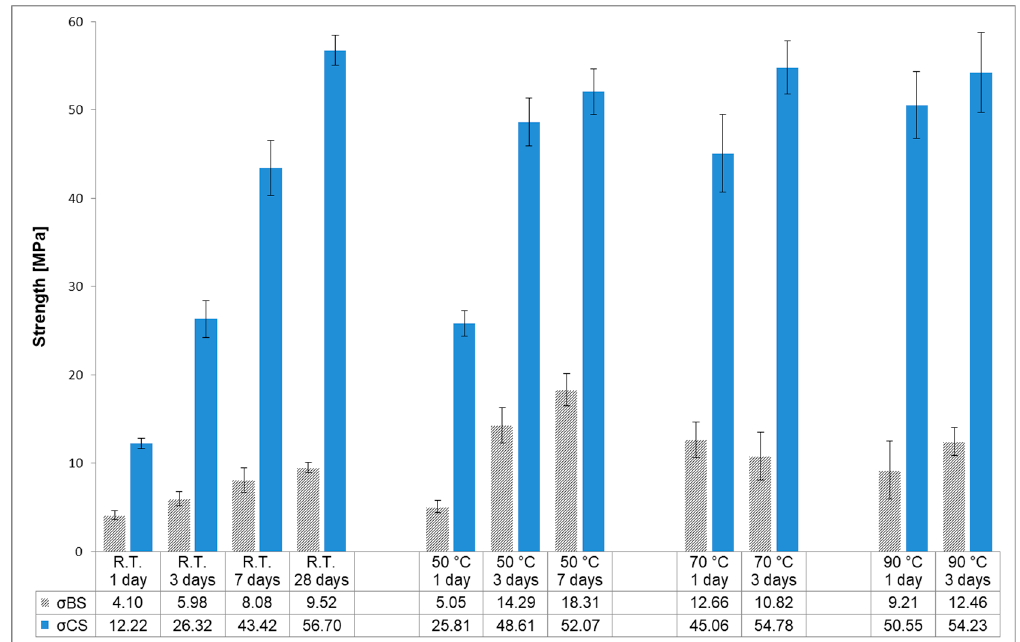
Figure 4. Bending ( σ BS) and compressive strengths ( σ CS) of A/R: 1/1 specimen cured at different temperatures (room temperature (R.T.), 50, 70 and 90 °C) and cured for different period of time.